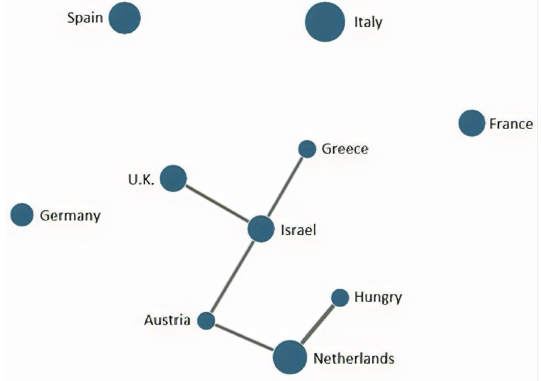
Figure 3. Matrix of academic collaborations between the top 10